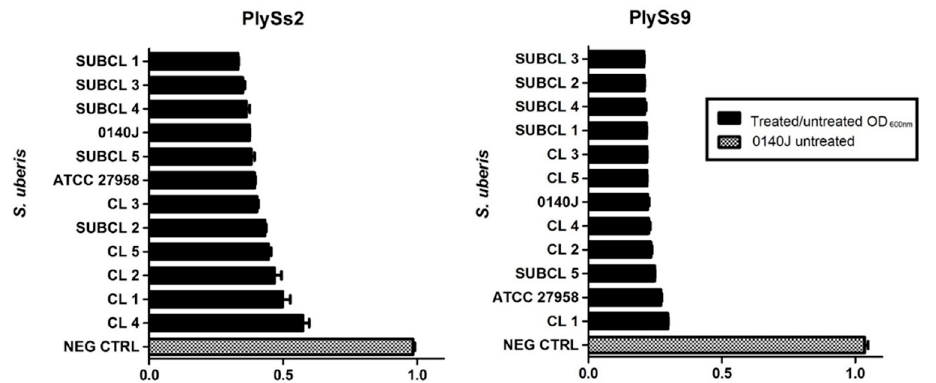
Figure 6. Reduction of the OD 600 of multiple subclinical (SUBCL) and clinical (CL) S. uberis strains and the references S. uberis 0140J and ATCC 27,958 after 1 h incubation at 37 °C with 0.5 µM of PlySs2 and PlySs9. S. uberis 0140J in PBS served as the negative control (NEG CTRL).